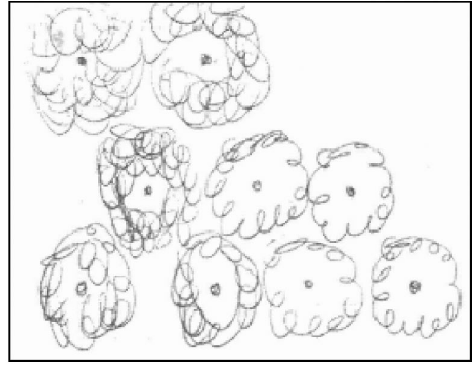
FIG. 2. Student model of an atom.